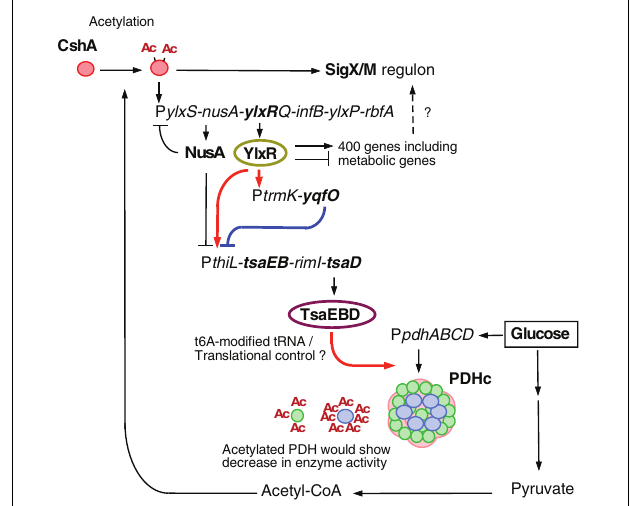
FIGURE 7 | Suggested model of glucose-responsive system (GRS). The thick lines show the regulatory pathways identified and analyzed in this paper. The other pathways have been analyzed in Ogura and Asai, 2016 (acetylation of CshA and sigX/M regulation), Ogura and Kanesaki, 2018 (CshA-dependent regulation of P ylxS driving expression of YlxR, which regulates metabolic genes), and Mondal et al., 2016 (NusA inhibits P ylxS and P thiL ). With respect to PDHc, this cartoon does not correctly reflect the actual structure (Zhou et al., 2001). Green circle, PdhE1 ( pdhA and pdhB ); blue circle, PdhE3 ( pdhD ); pink moiety, PdhE2 core ( pdhC ). PDHc is also known to be acetylated (under glucose-rich conditions, at 3 moieties of PdhA and 7 moieties of PdhD, Kosono et al., 2015), and acetylation reduces enzyme activity. Arrows indicate transcription, translation, acetylation, enzyme reaction, protein association or transcriptional activation. T-bars indicate transcriptional repression or attenuation. Ac, acetyl moiety; PDHc, pyruvate dehydrogenase complex; RNAP, RNA